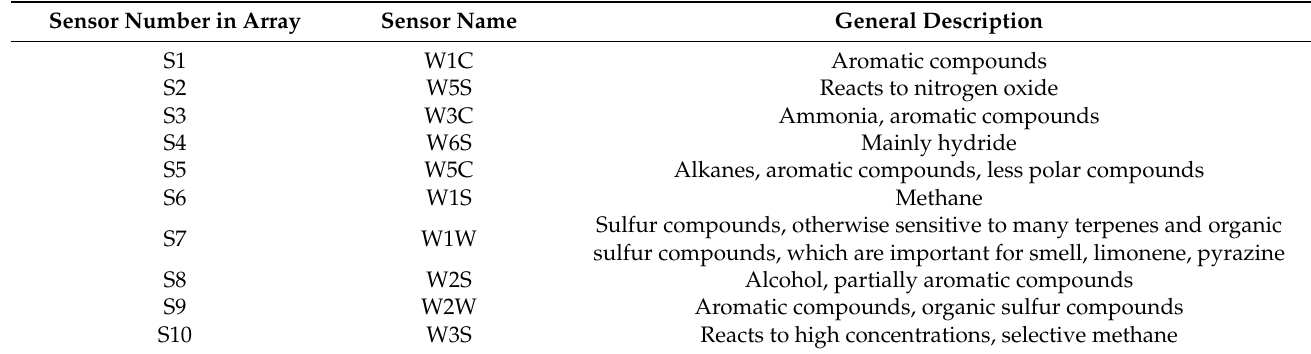
Table 2. Performance of 10 sensors for PEN 3 electronic